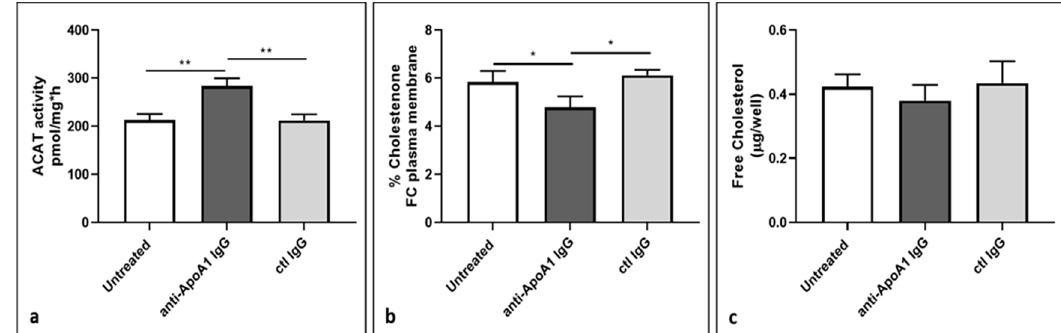
Figure 7. Effect of anti-ApoA-1 IgG on cholesterol distribution. ( a ) Cells were incubated for 24 hours in RPMI medium with 10% FCS, control IgGs, or anti-ApoA-1 IgG. Monolayers underwent a second